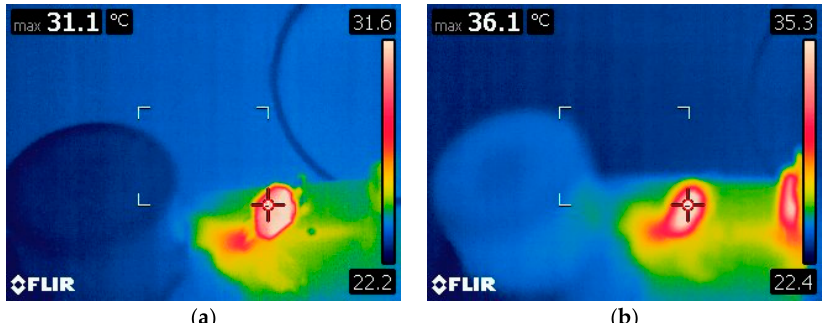
Figure 12. Thermal camera view of IGBT with 150 W/m 2 when ( a ) P&O and ( b ) IC are used.